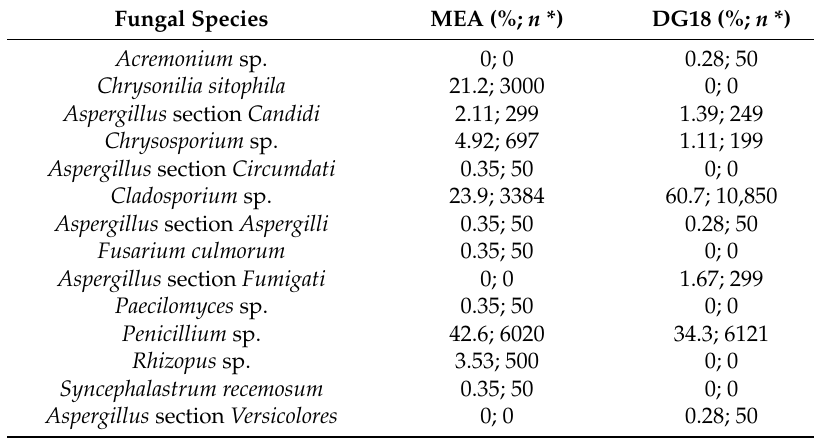
Table 3. Fungal distribution after EDC inoculation on to malt extract agar (MEA) and dichloran glycerol (DG18) media.